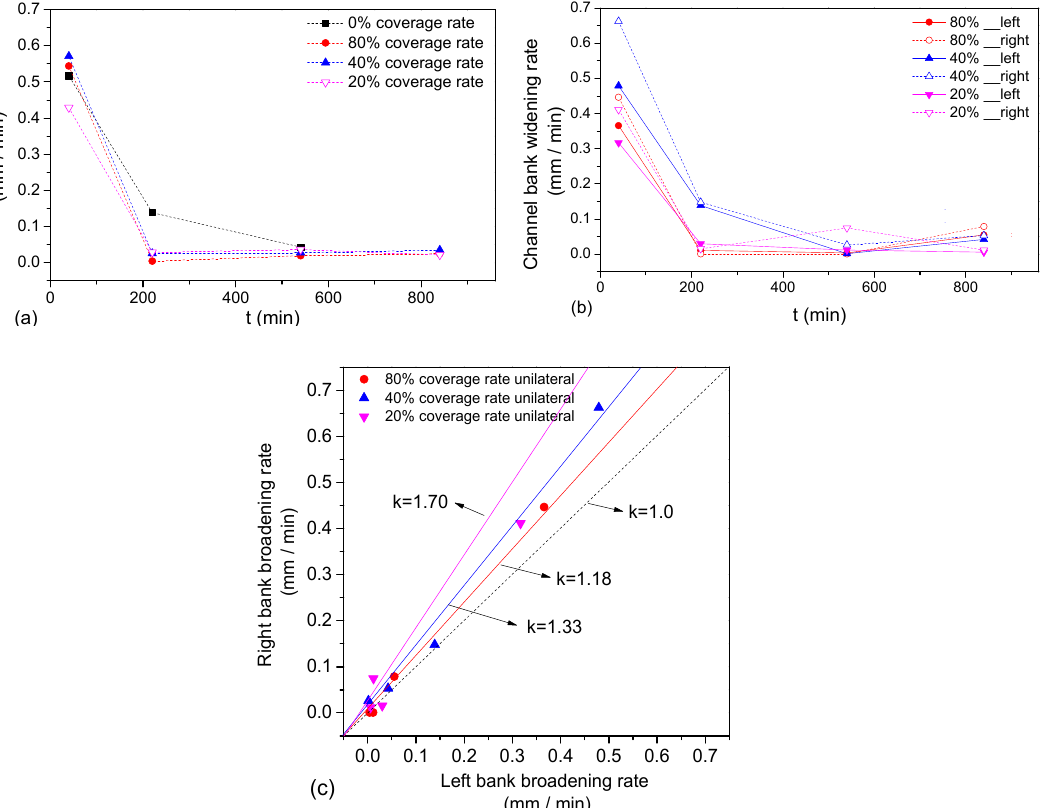
Figure 13. Temporal evolution of river banks: ( a ) bilateral vegetation cover and ( b ) unilateral vegetation cover; ( c ) the relationship between the widening rate of right bank and left bank. Table 3. Average channel bank widening rate of bilateral vegetation cover.